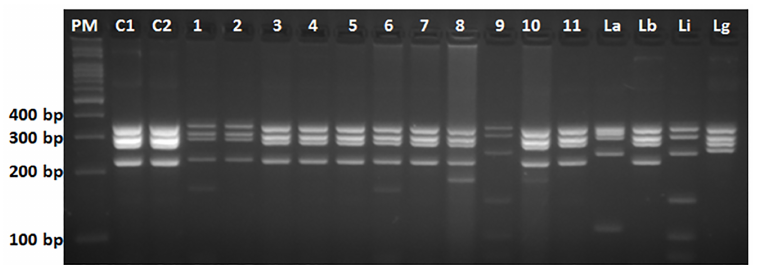
Fig 2. Results of PCR RFLP hsp 70. PM: 100bpmolecularweight marker. C1 and C2:DNA samplesof isolatedparasites. 1 to 11: DNA samples of small mammals. La: L . (L . ) amazonensis (IFLA/BR/1967/PH8); Lb: L . (Viannia)braziliensis (MHOM/BR/1975/M2903); Li: L . (L . ) infantum (MHOM/BR/1974/PP75); and Lg: L . (V . ) guyanensis (MHOM/BR/1975/M4147).